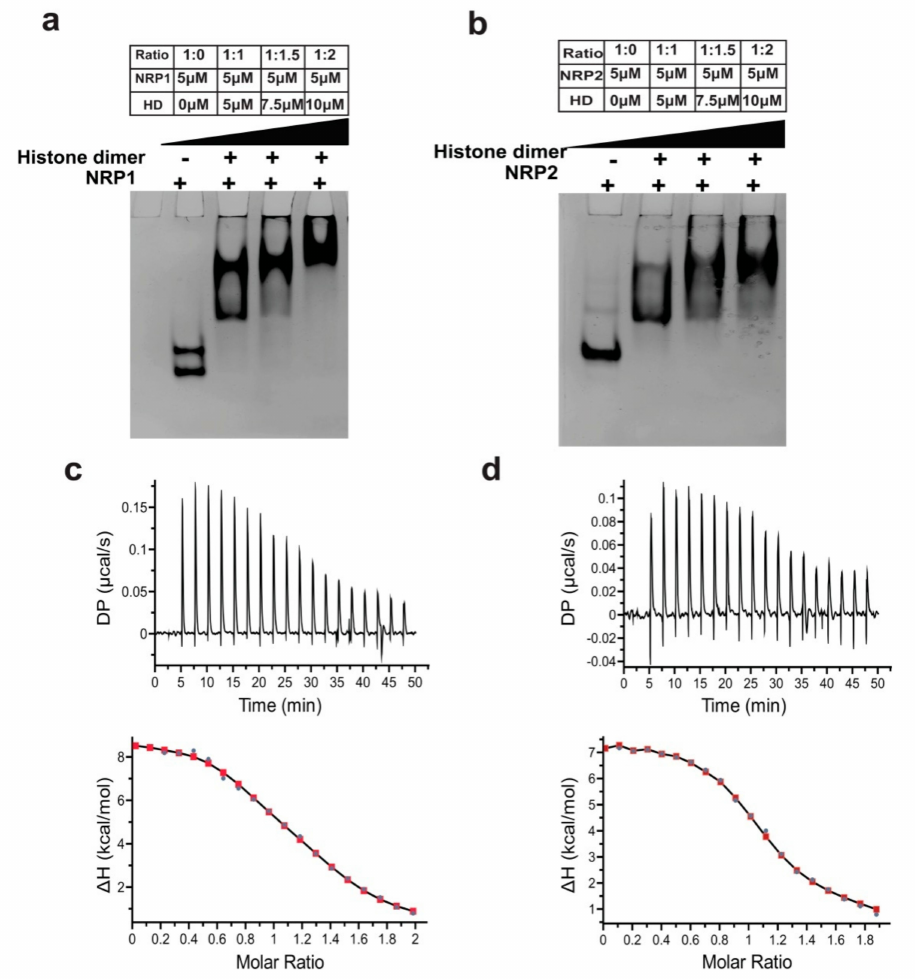
Figure 9. Interaction of AtNRP1 / AtNRP2 with histone H2A-H2B dimer. Electrophoretic mobility shift assay for the binding of histone dimer with ( a ) full-length AtNRP1 and ( b ) full-length AtNRP2. ( c ) The binding isotherm of full-length AtNRP1: H2A-H2B. ( d ) The binding isotherm of full-length AtNRP2: H2A-H2B. The top panel represents the sequential injection of AtH2A-H2B into AtNRP1 and bottom represents integrated heat data after correction for the heat of dilution. The data fitting was done using sequential binding model. (Red rectangles represent experimental fit and grey circles represent actual